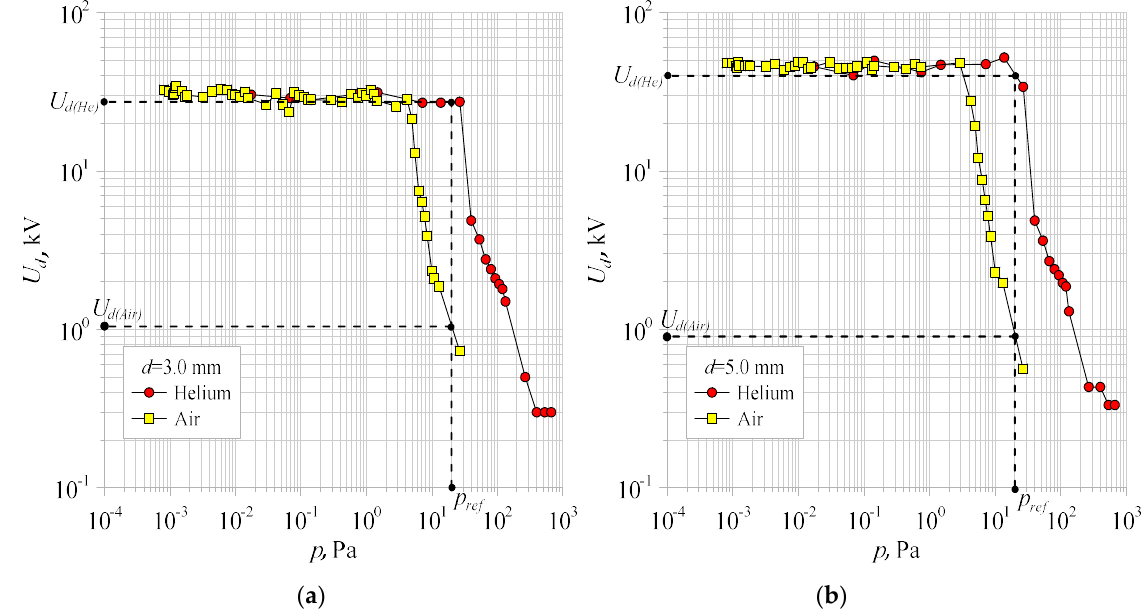
Figure 8. Comparison of the dielectric strength of a vacuum interrupter filled with air and helium for two electrode spacing: ( a ) 3.0 mm, ( b ) 5.0 mm.